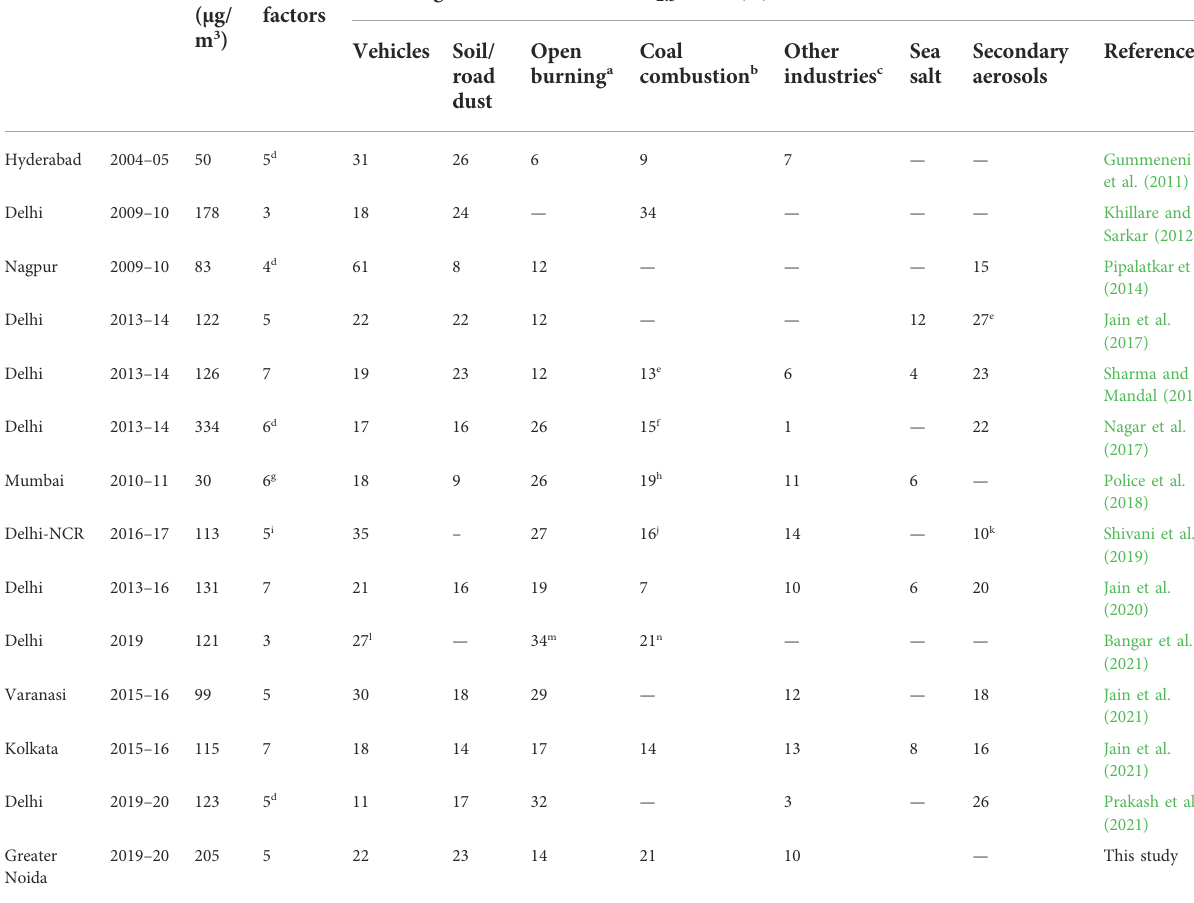
TABLE 1 Summary of the results of source apportionment of PM 2.5 in Delhi-NCR and other Indian cities. Location Period PM